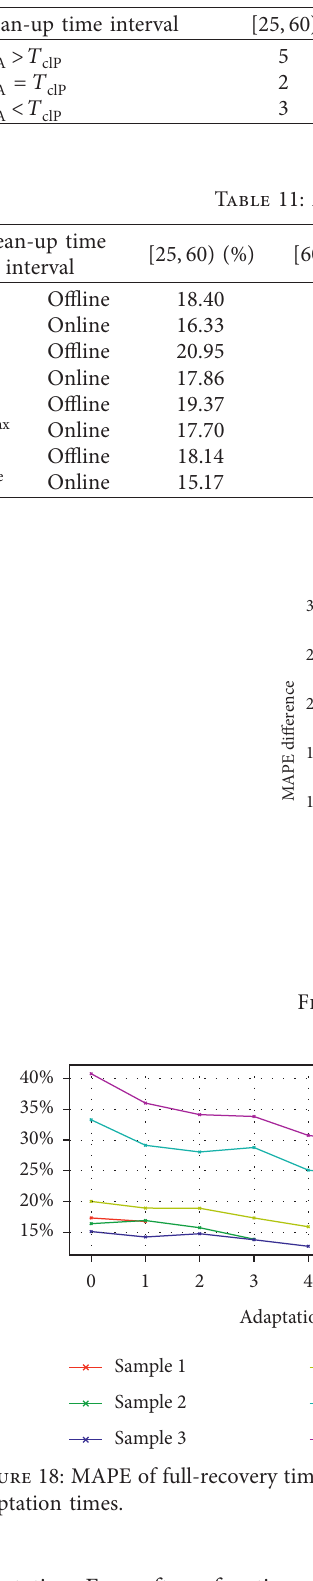
Table 10: Clean-up time differences distribution in intervals.